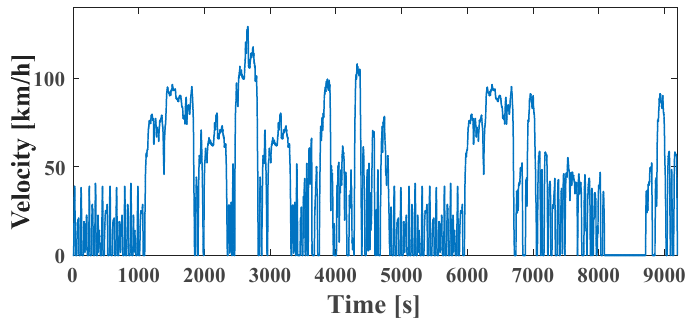
Figure 3. Training process of the learning vector quantization (LVQ) neural network.